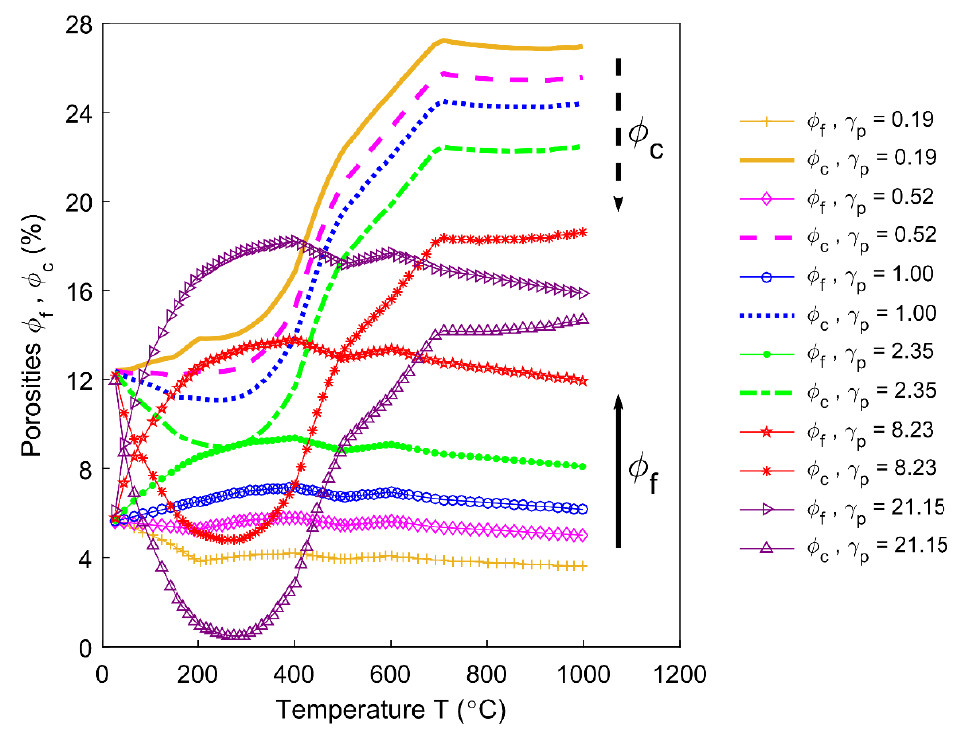
Figure 17. Sensitivity analysis of porous structures for different permeability correlators.